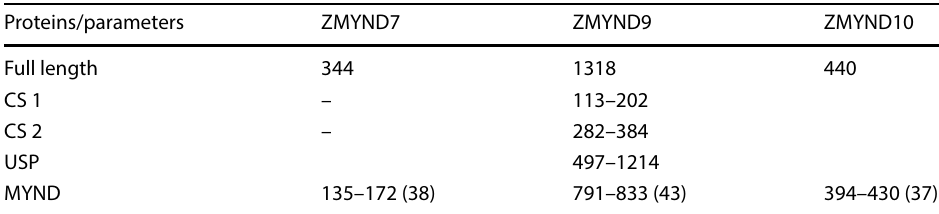
The linear structure shows that USP19/ZMYND9 contains additional functional regions C1, C2 and USP which possesses catalytic activity of ubiquitin protease. The numbers denote the position of amino acid residues, and those in brackets showing the length of the fragment. The three proteins share the domain